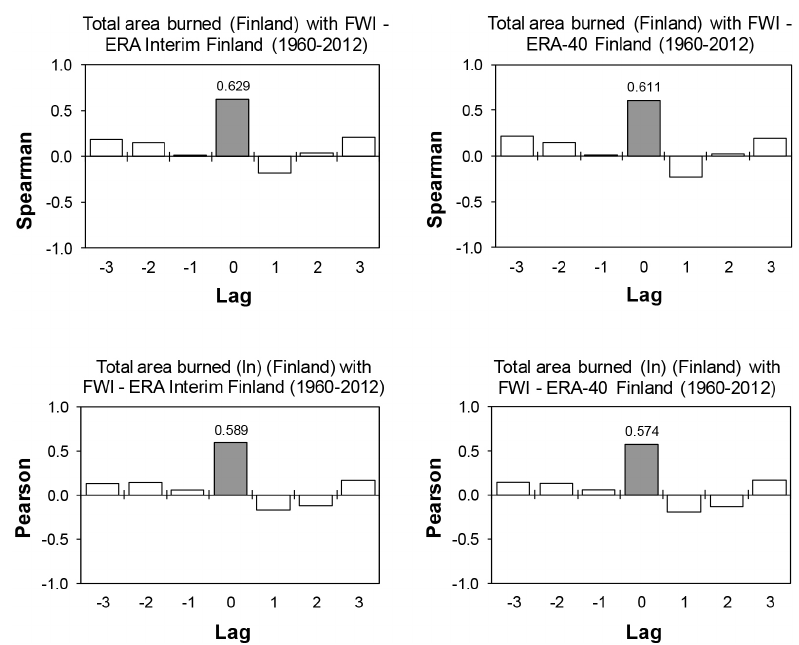
Figure 11. Cross-correlation graphs between total burned area (original and ln-transformed) at the national scale in Finland and FWI values estimated from ERA-40 and ERA Interim Finnish data for the period 1960–2012 (grey columns indicate significant values at the 95% confidence